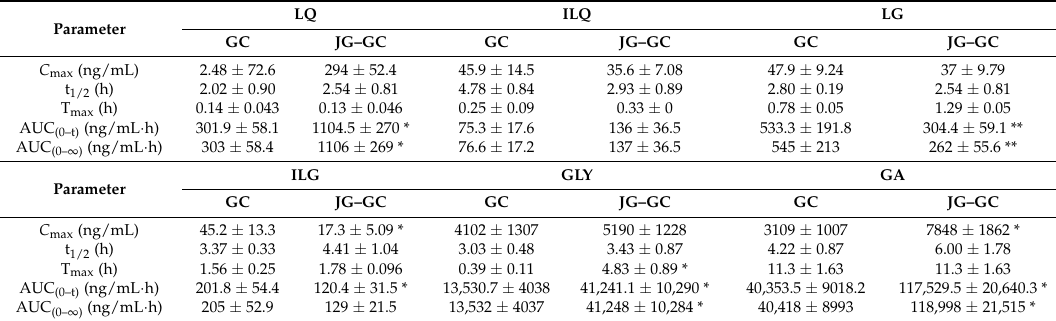
Table 1. Pharmacokinetic parameters of the analytes in rat plasma after oral administration of Gancao (GC) and Jiegeng (JG)–GC (mean ± SD, n =